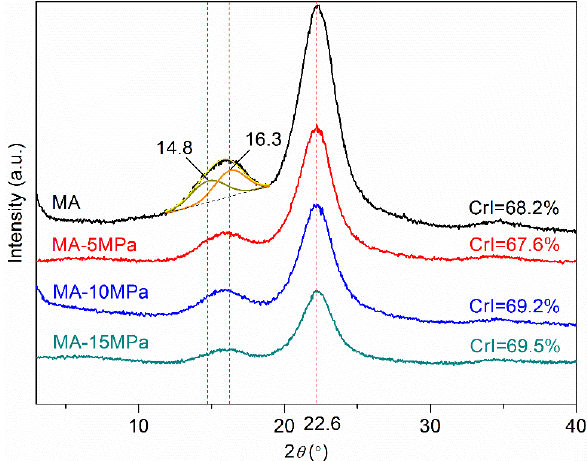
Figure 3. XRD profiles of the MA sample and the all-wood biocomposites with different hot-pressing pressures.